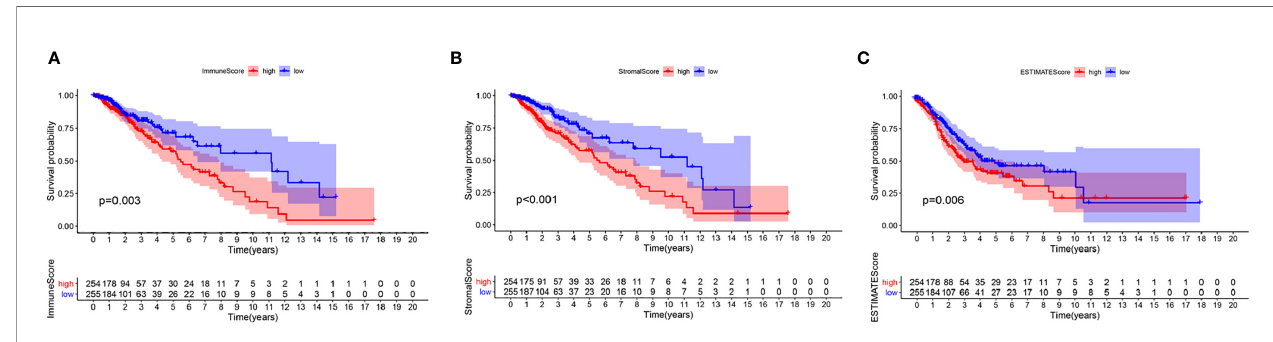
FIGURE 2 | Correlation of scores with the survival of patients with LGG. (A) Kaplan-Meier survival analysis for LGG patients grouped into high or low score in ImmuneScore determined by the comparison with the median, P = 0.003. (B) Kaplan – Meier survival curve for StromalScore, p < 0.001. (C) Survival analysis with Kaplan – Meier method for LGG patients grouped by ESTIMATEScore, P